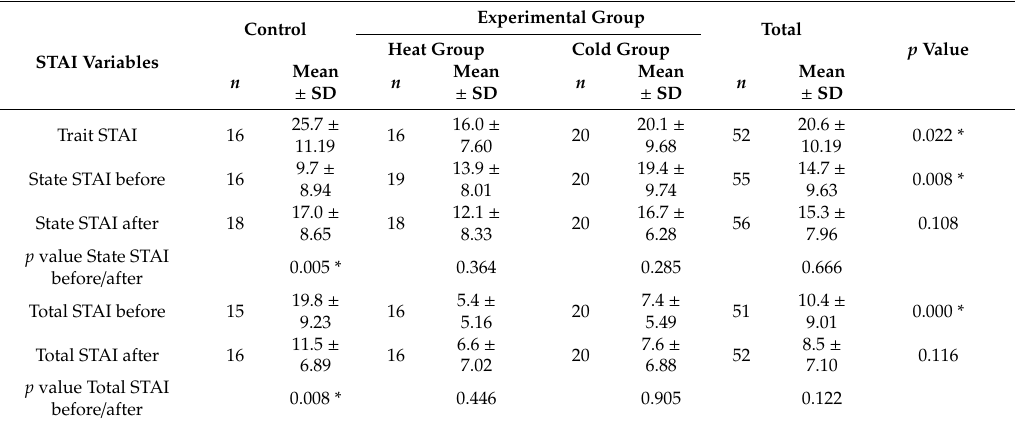
Table 2. Variables according to experimental